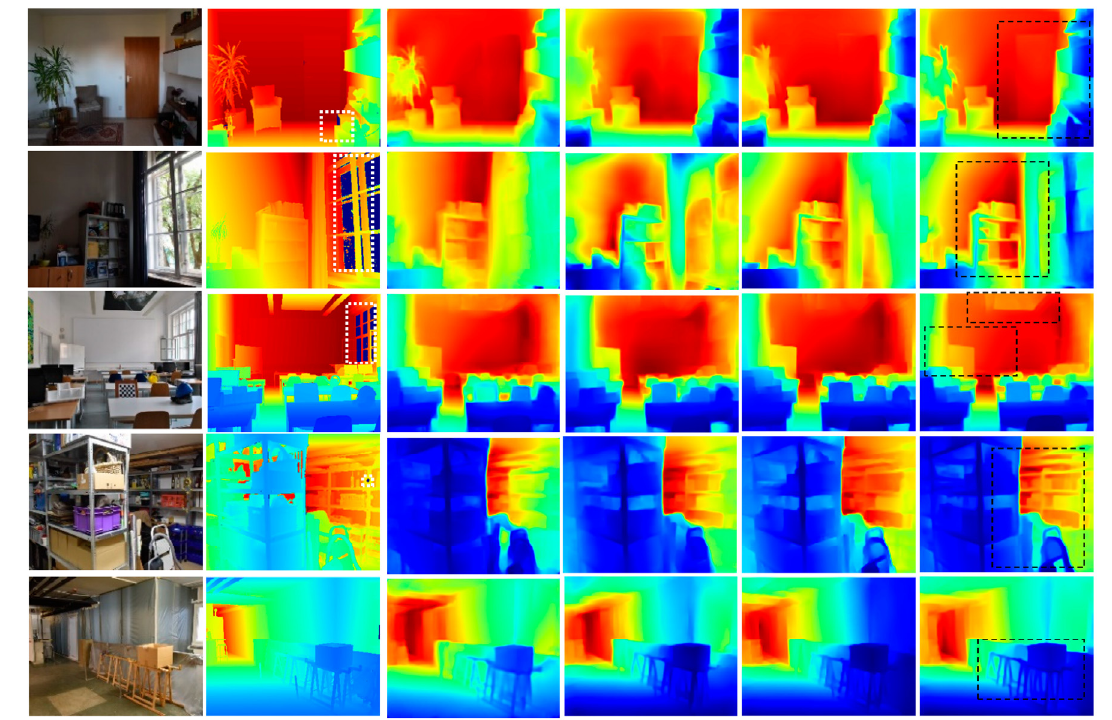
Figure 10. Cross-validation trained on NYU-Depth-V2 and tested on the iBims-1 datasets. Columns from left to right: original RGB images, ground truth depth maps, Alhashim et al. [17], Hu et al. [22], Chen et al. [20], and the proposed method. Regions in white boxes show missing or incorrect depth values from the ground truth data. Regions in black boxes highlight the better-predicted results. Colors indicate depth; red is far, and blue is close.